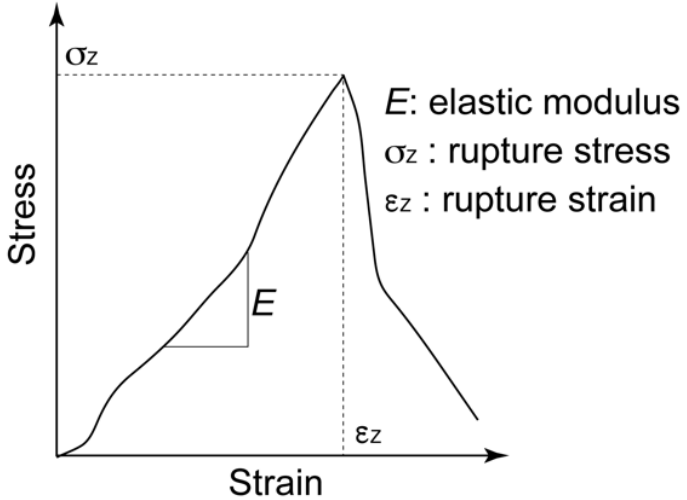
Figure 6. Definition of elastic modulus ( E ), rupture stress ( σ z ), and rupture strain for the stress–strain curve of the gel-sheet laminated construct.